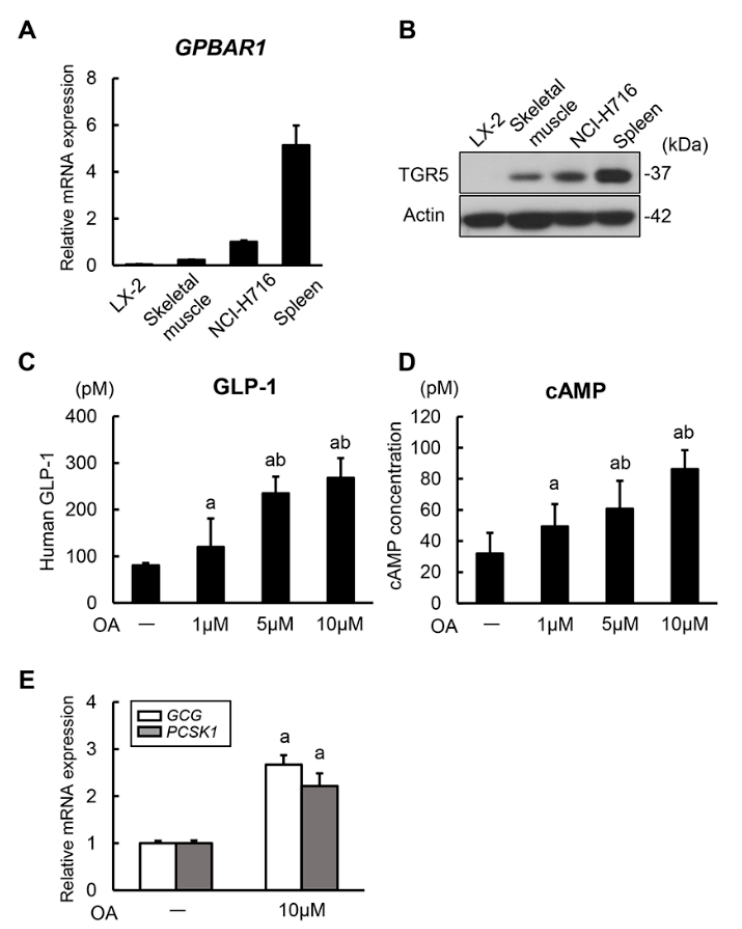
Figure 1. GLP-1 synthesis and secretion in human intestinal cells. ( A ) Relative mRNA expression levels of human GPBAR1 . Quantitative values are indicated as ratios to the values of NCI-H716. Human skeletal muscle and spleen tissues were used as controls. ( B ) Western blots of whole cell lysates for the expression of TGR5. Actin was used as internal control for western blotting. ( C ) Measurement of human GLP-1 concentrations in NCI-H716 cell-cultured media. NCI-H716 cells were cultured with different concentrations of oleanolic acid (OA) for 2 h. ( D ) Measurement of human intracellular cAMP concentrations in NCI-H716 cells. NCI-H716 cells were cultured with different concentrations of oleanolic acid for 2 h. ( E ) Relative mRNA expression levels of human GCG and